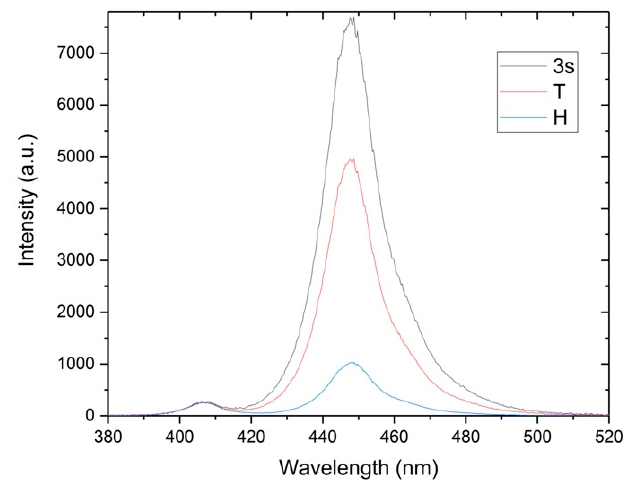
Figure 3. The emission spectrum of the Bluephase PowerCure in the 3s, turbo (T), and high power (H) curing mode.